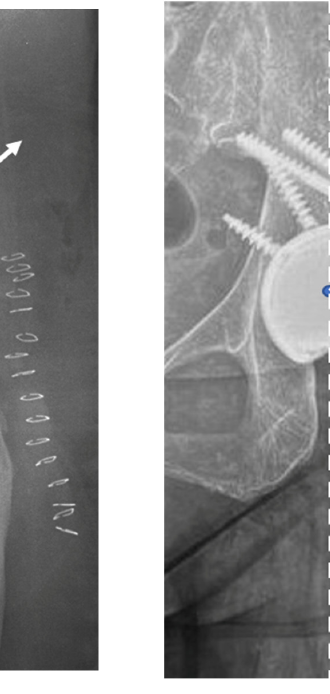
Figure 3. Center-edge angle: CE I, CE II, CE III.